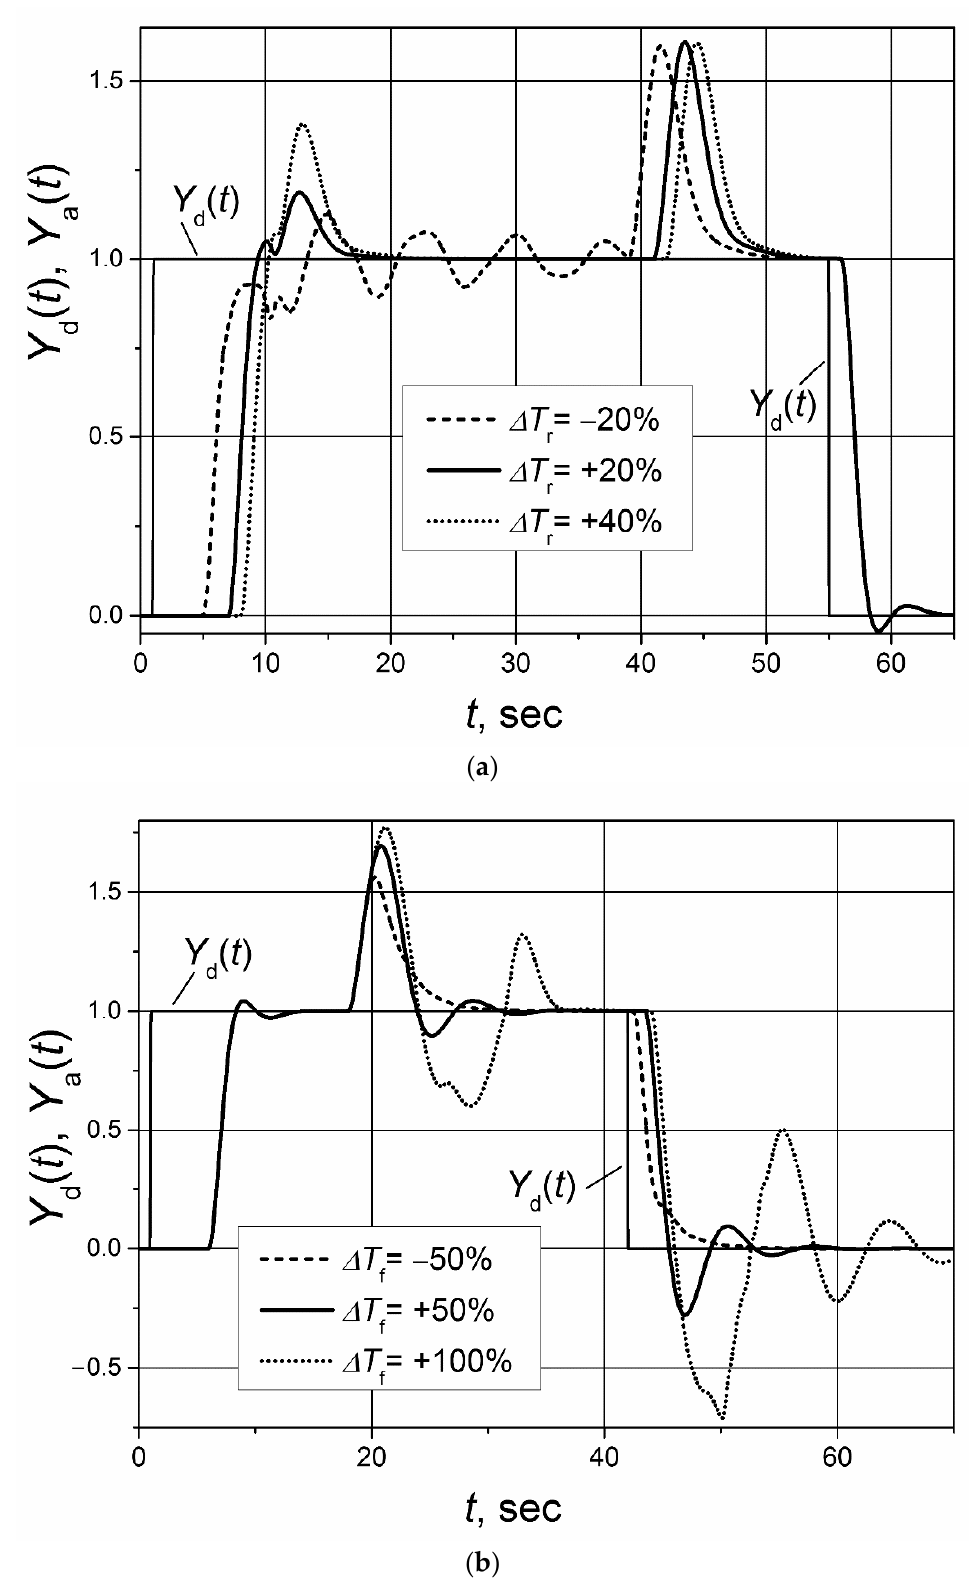
Figure 11. The set-point unit pulse and unit-load disturbance responses of the control system of the second-order plant with asymmetric response delay based on the PI controller with the switched-delay Smith predictor when plant-response delay changes: ( a ) changes just T r by value ∆ T r ; ( b ) changes just T f by value ∆ T f . Unit-load disturbances occur at times: ( a ) t = 35 s; ( b ) t = 13 s.